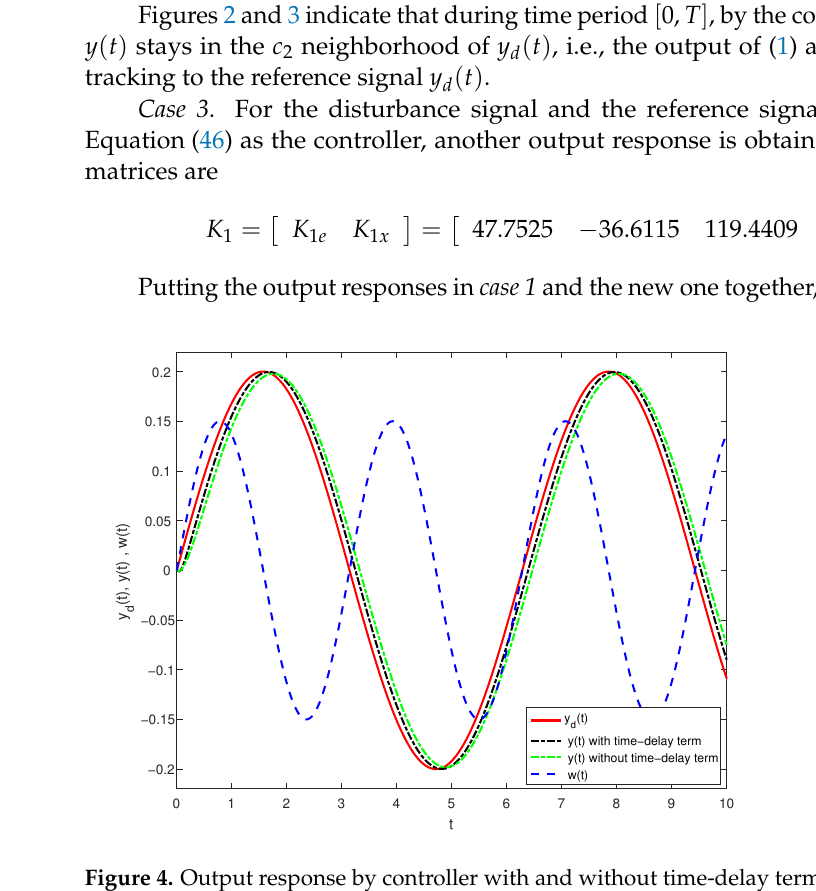
Figure 4. Output response by controller with and without time-delay